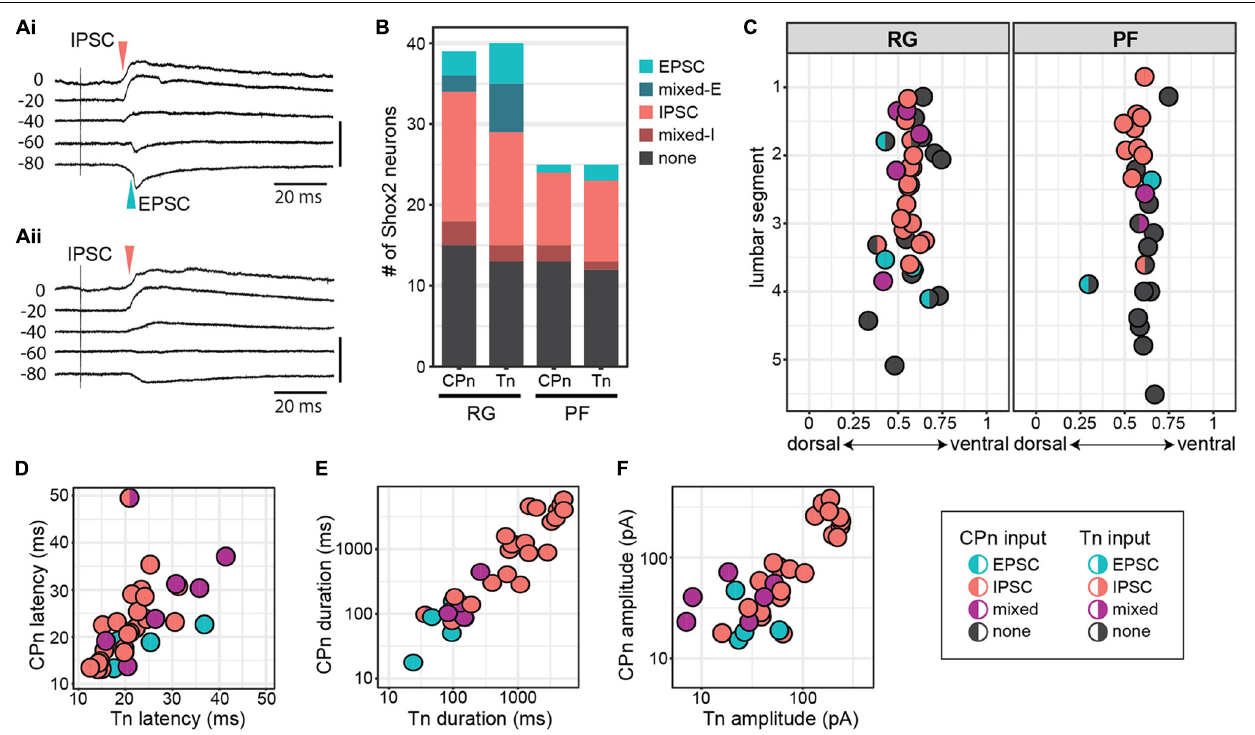
FIGURE 4 | Shox2 neurons which respond to CPn and Tn stimulation respond similarly to both. (A) Example traces showing intracellular currents measured from two Shox2 neurons at various membrane holding potentials following Tn stimulation at 2 × T. (Ai) A mixed-E response showing inhibitory outward currents (red arrow, upward deflection) followed by excitatory inward currents (green arrow, downward deflection). (Aii) A response showing only inhibitory currents with a reversal potential near –60 mV. (B) Postsynaptic current types detected in Shox2 RG and Shox2 PF neurons following stimulation of CPn and Tn. (C) Shox2 RG and Shox2 PF neurons at multiple segmental levels receive postsynaptic currents following CPn and Tn stimulation. Shox2 neurons responding to CPn were significantly more likely to respond to Tn as well ( χ 2 = 31.99, df = 1, p = 1.55e-08). Dual responding Shox2 neurons showed a significant association between responses (EPSC, IPSC, mixed) following CPn and Tn stimulation ( χ 2 = 60.06, df = 4, p = 2.82e-12), with IPSCs being most common. Data shown as a plot with neuronal position. (D–F) In neurons which received postsynaptic currents following CPn and Tn stimulation, response latency, duration and amplitude were positively correlated between CPn and Tn response (linear regression, latency: adjusted R 2 = 0.32, slope = 0.50, t = 4.00, p = 0.0004; duration: adjusted R 2 = 0.77, slope = 0.83, t = 10.35, p = 1.41e-11; amplitude: adjusted R 2 = 0.68, slope = 0.61, t = 8.35, p = 1.95e-09). Duration and amplitude plotted on log scale for